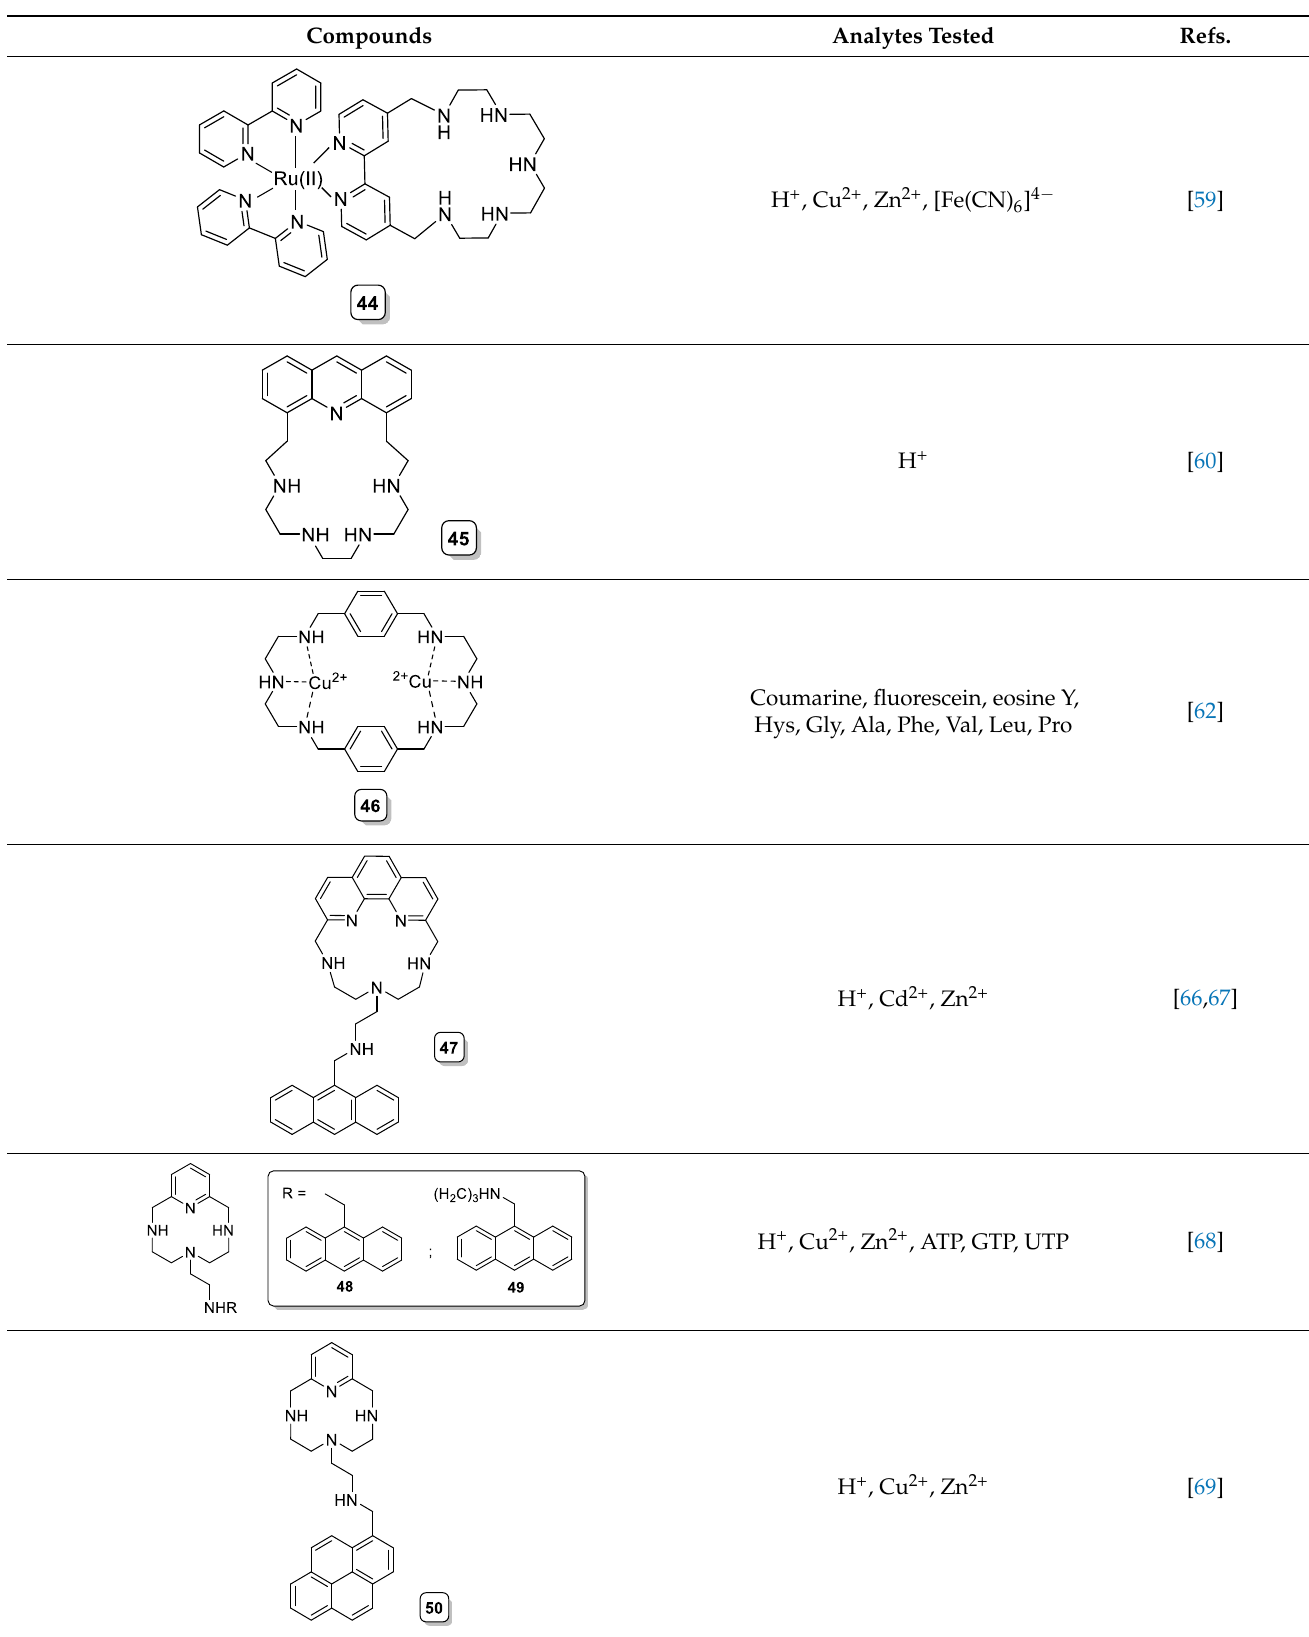
Table A1. Cont. Compounds Analytes Tested